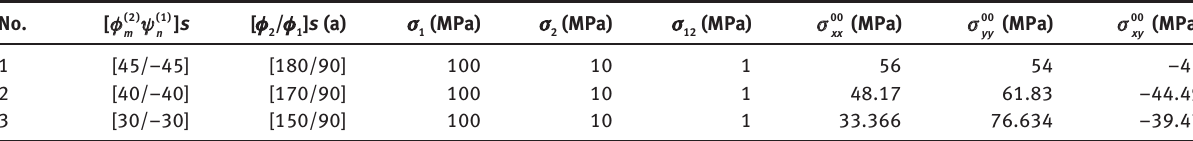
Table 2: Local and global loads of several laminates.